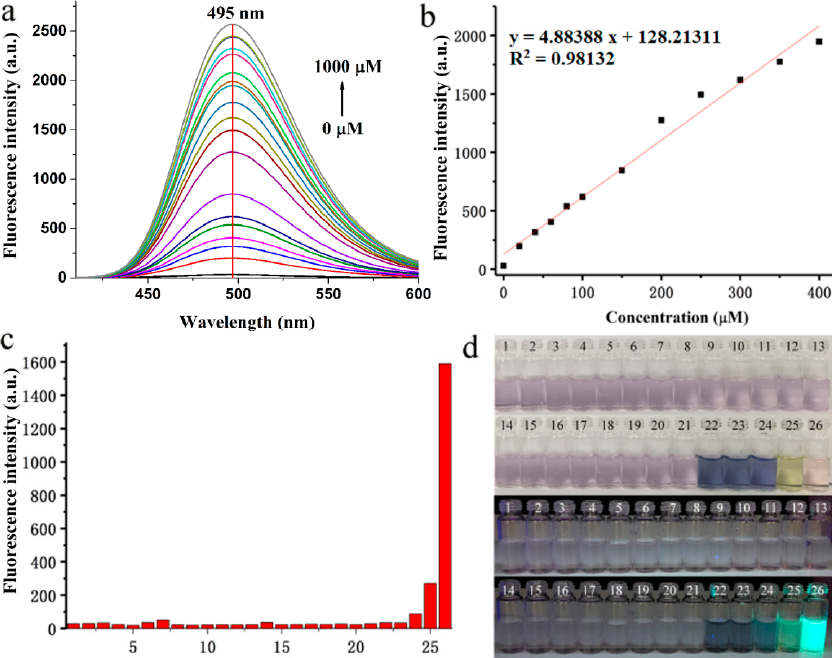
Figure 2. Fluorescence responses of BPO-DNSP to SO 2 . ( a ) Fluorescence responses of BPO-DNSP (10 μ M) to different concentrations of SO 2 (0–1000 μ M); ( b ) Plot of BPO-DNSP fluorescence intensity to 0–400 μ M SO 2 at 495 nm; ( c ) fluorescence intensity and ( d ) color changes of BPO-DNSP (10 μ M) treated with 500 μ M of various relevant analytes. λ ex = 390 nm. Slit: 2.5 nm/5 nm. 1. BPO-DNSP , 2.